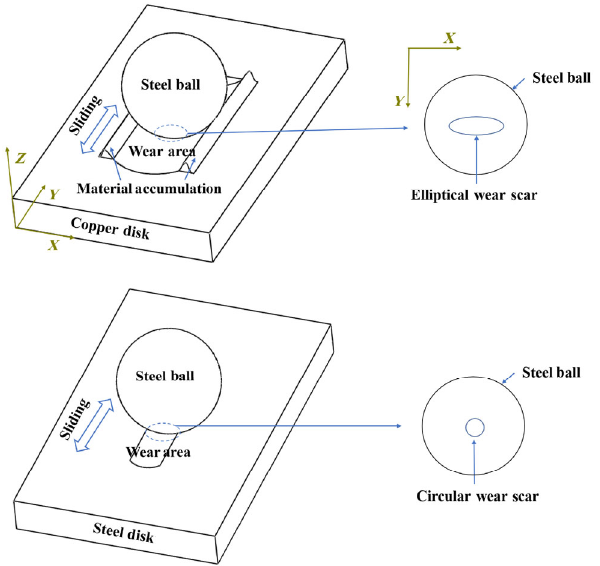
Fig. 12 Wear scars of the steel balls, copper disk and steel disk after